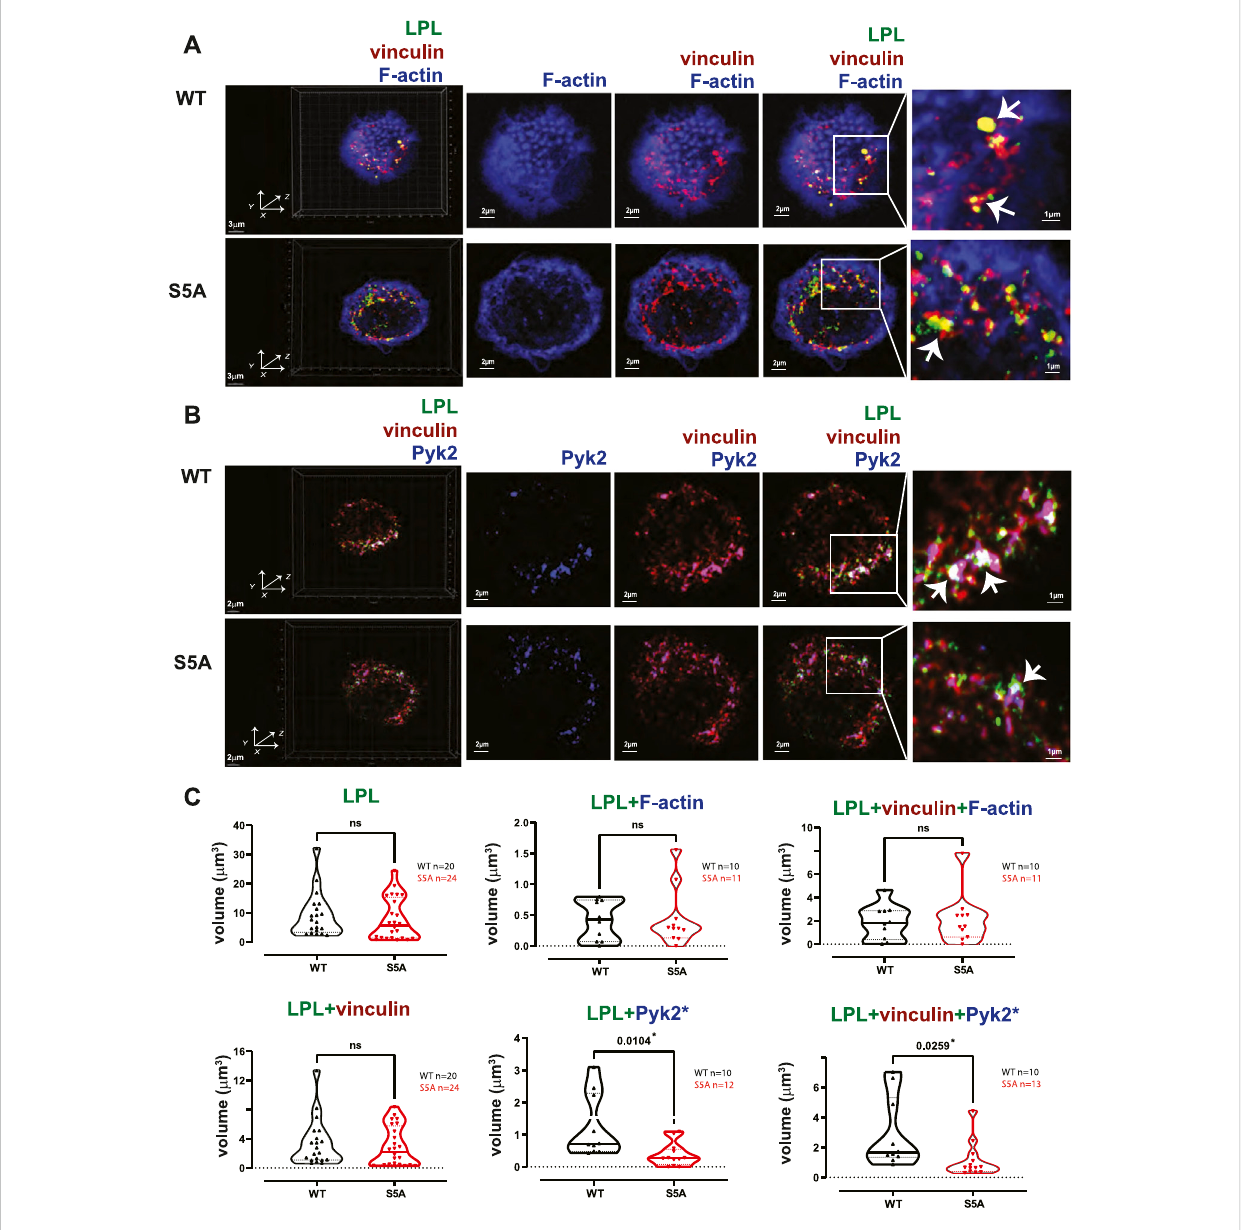
FIGURE 8 Co-localization of S5A-LPL with Pyk2, but not vinculin, diminished in AMs incubated for 60 min after isolation. (A, B) Co-localization of (A) LPL (green), vinculin (red) and F-actin (blue) or of (B) LPL (green), vinculin (red) and Pyk2 (blue) in AMs from matched WT and S5A mice, imaged after 60 min incubation on glass coverslips without additional stimulation. Images in left panels show 3D reconstruction of Z-stack confocal micrographs. Other panels are 2D XY projections showing F-actin only; overlay of (A) vinculin + F-actin (purple), or (B) vinculin + Pyk2; or (A) overlay of LPL + vinculin + F-actin (white) or (B) LPL + vinculin + Pyk2 (white). Representative podosomes are indicated by white arrows and magni fi ed in insets. Grids show 2 μ m increments and are optimal for size assessment; scale bars in subsequent panels are derived from grids. (C) Total volume of aggregates of LPL, LPL + vinculin, LPL + F-actin, LPL + Pyk2, LPL + vinculin + F-actin, and of LPL + vinculin + Pyk2. Each symbol represents the volumes calculated from one AM; n = number of cells analyzed. Images acquired from two independent experiments. p -values determined by Mann-Whitney; ns = non-signi fi cant, * p <